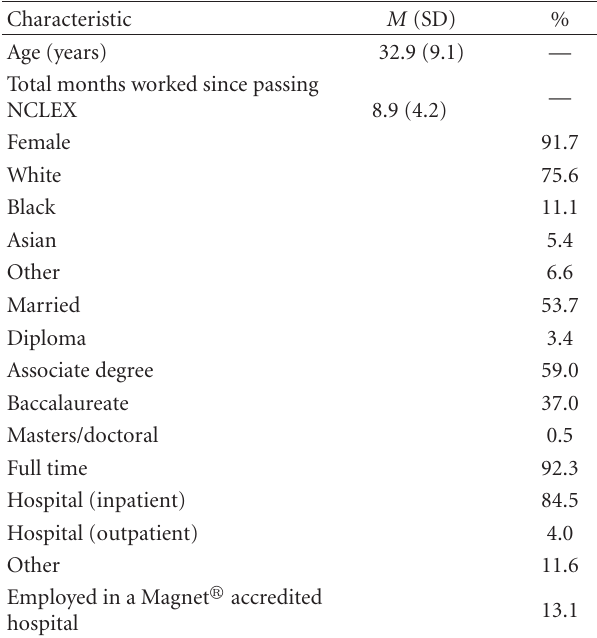
Table 1: Sample demographics ( N =